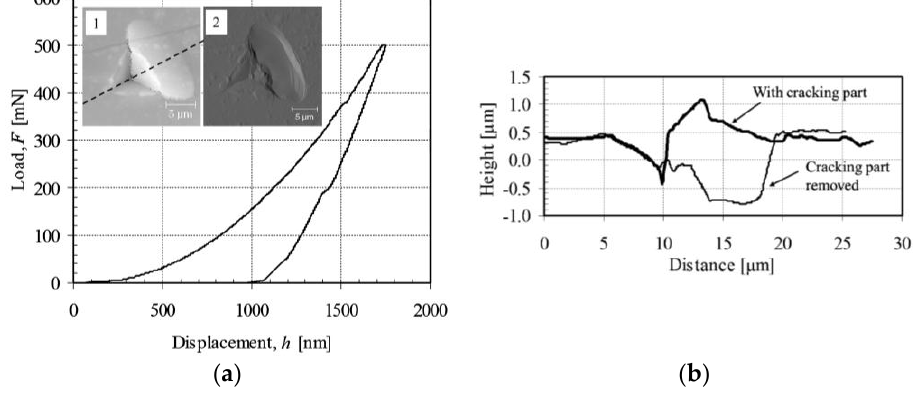
Figure 5. AFM images of typical indent impression of as-deposited (ZrO 2 -MMT) 30 multilayers with MMT 0.03 wt % ( a ) and corresponding cross-section profiles ( b ).